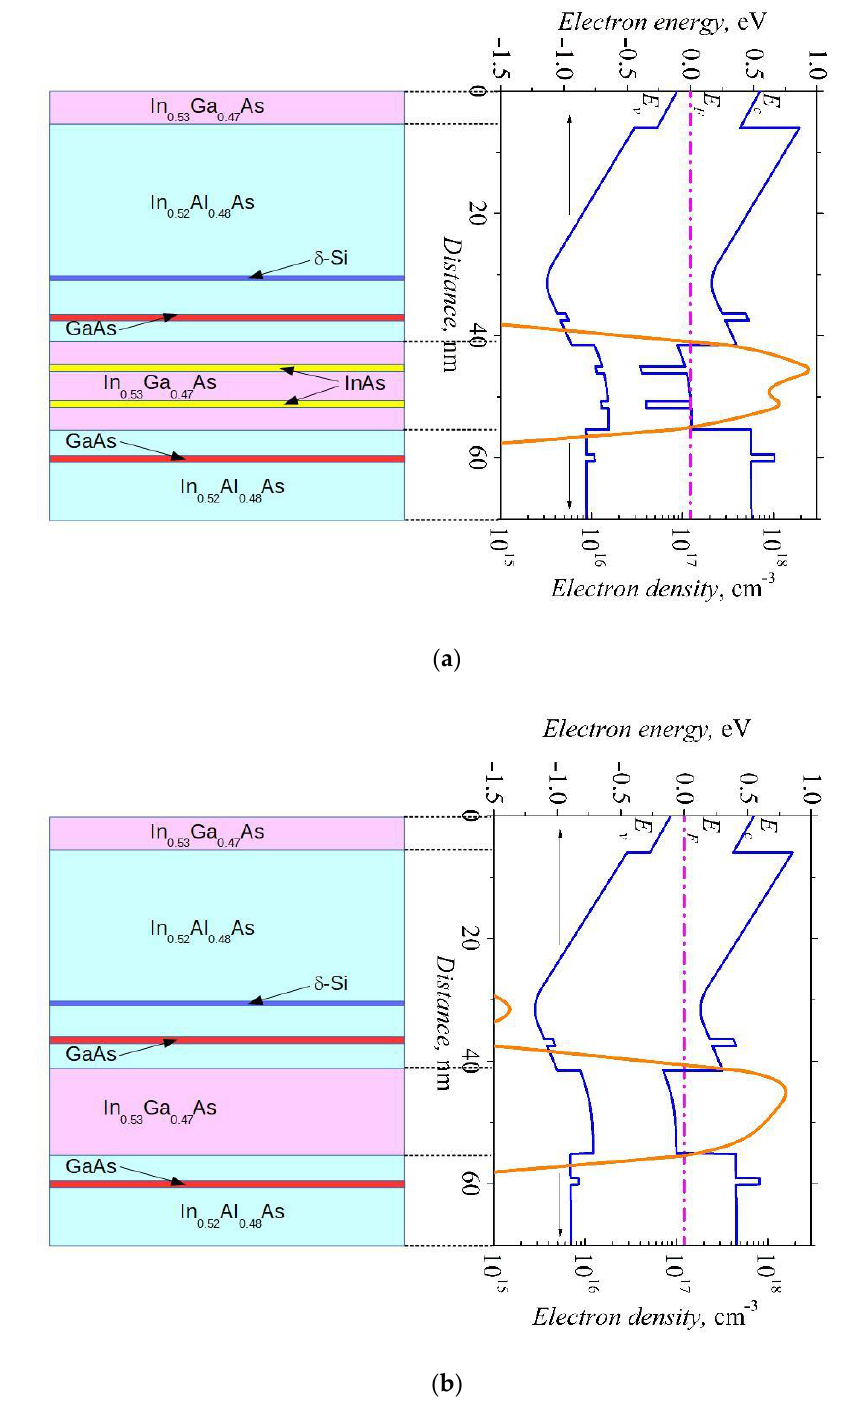
Figure A1. ( a ) The W heterostructure with the InAs inserts. ( b ) The WO heterostructure without the InAs inserts.